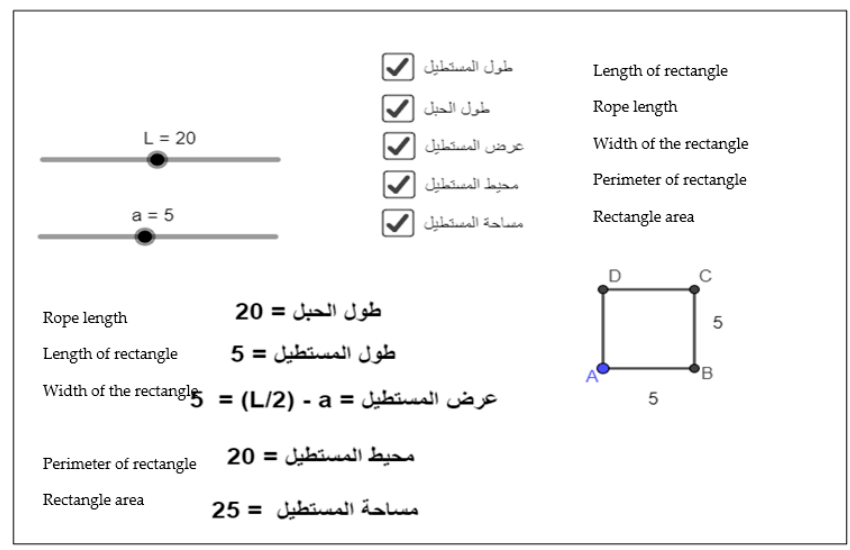
Figure 3. Applet for revealing the intuitive error—same circumference–same area. The participants revealed that they were wrong, and the same circumference did not produce the same area, as presented in their speech